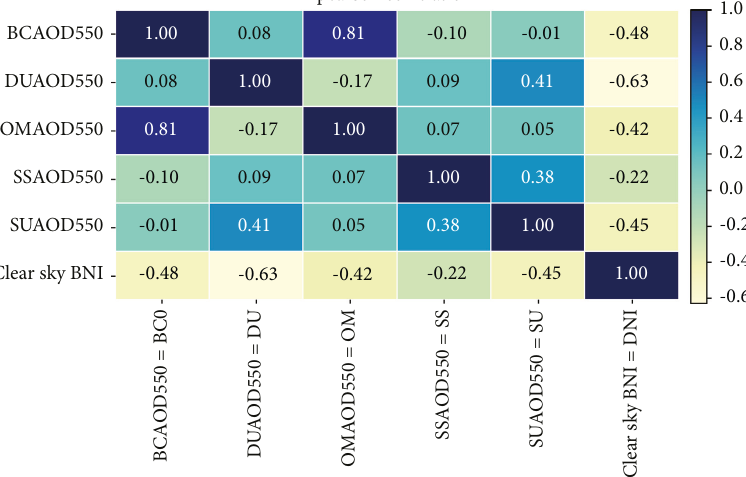
Figure 11: Pearson correlation matrix between five types of aerosols and Direct Normal Irradiation.